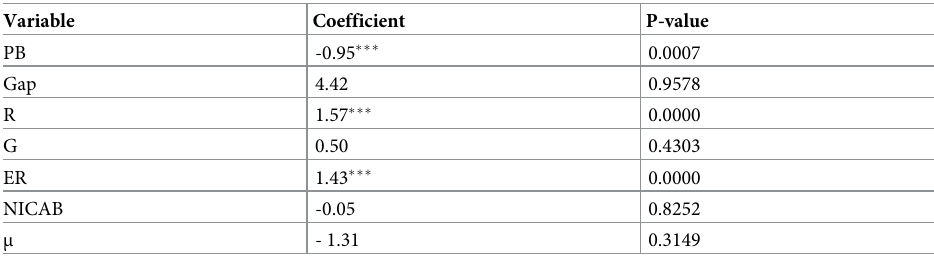
Table 5. Long run